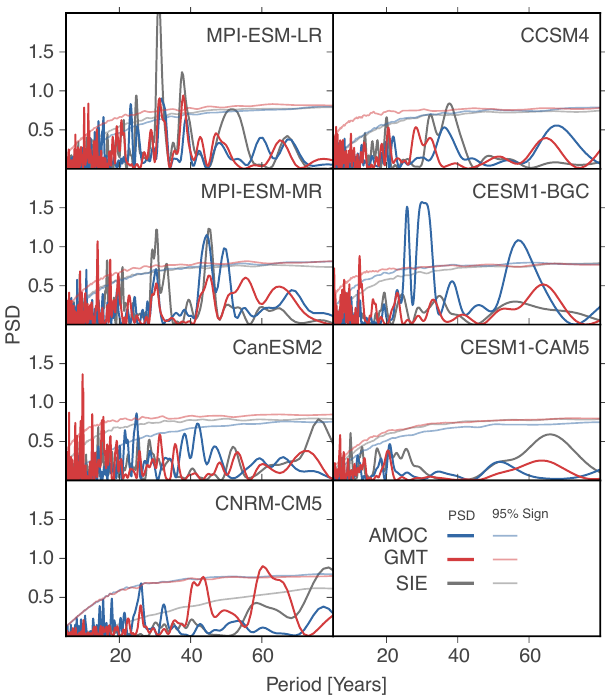
Fig. 2. Power spectral density of AMOC (blue), GMT (red) and SIE (grey). Light lines indicate the 95 % significance levels determined by a N=10000 ensemble of a red noise first order auto-regressive process fitted to each of the quantities. In this plot, all amplitudes are rescaled relative to the corresponding maximum of the 95 % significance level.